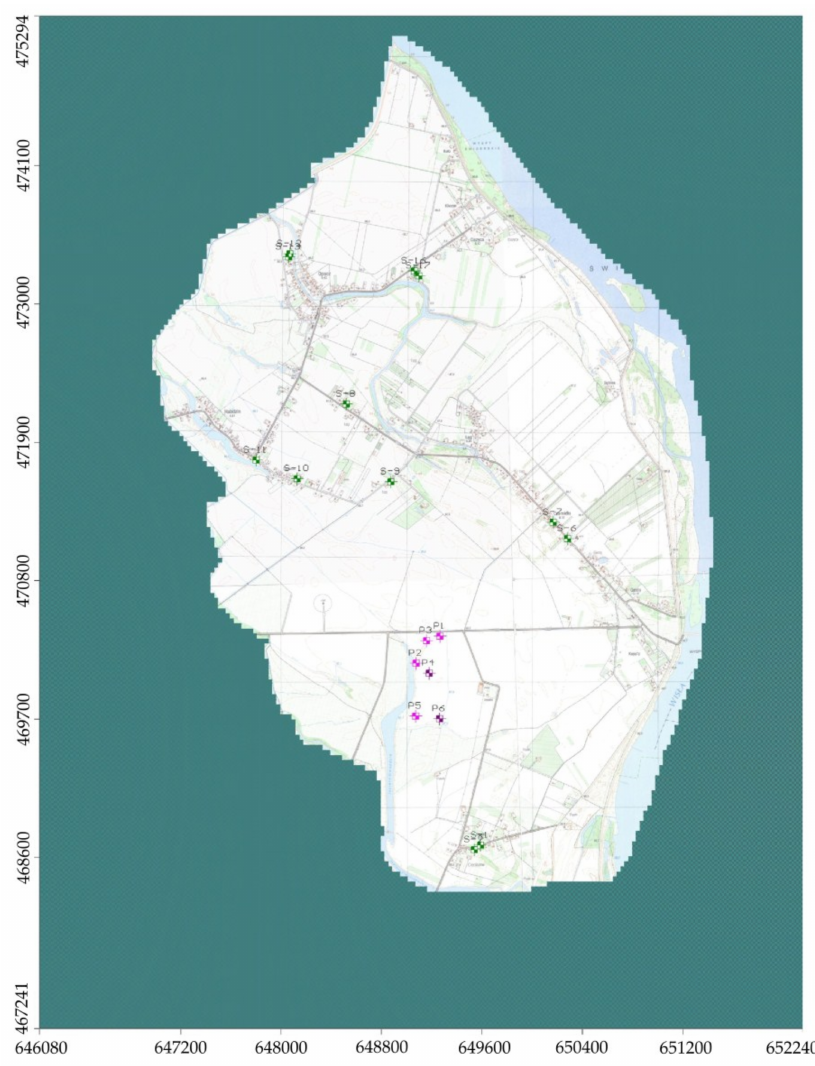
Figure 2. Monitoring network within the study area; green points represent dug wells, pink and violet points represent